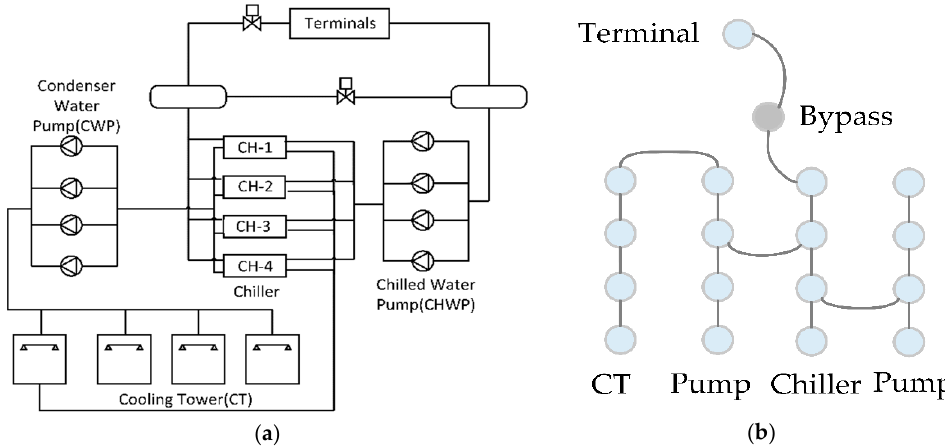
Figure 4. ( a ) Physical connection topology of the device; ( b ) Communication connection topology of the device.